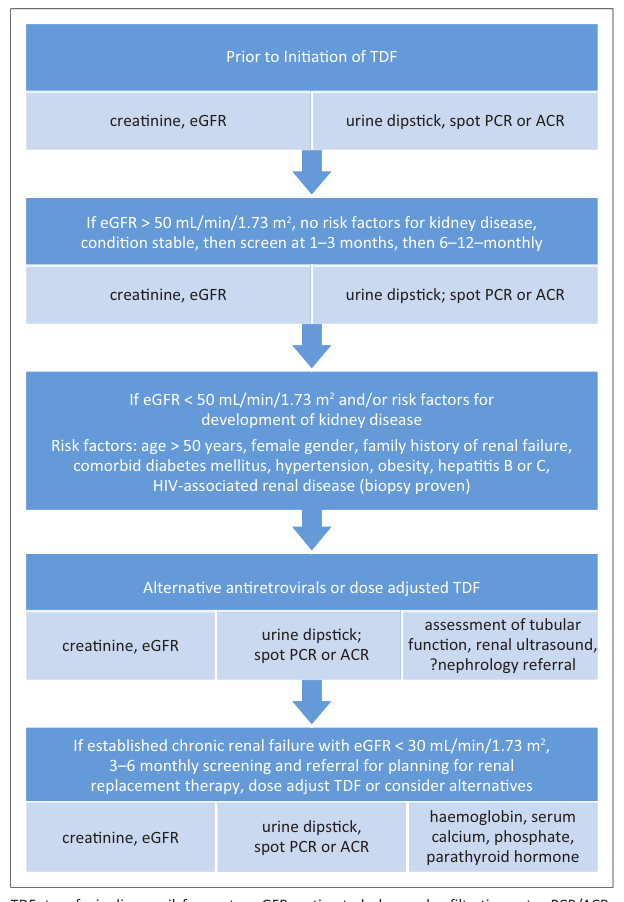
FIGURE 2: Proposed renal screening for those on tenofovir disoproxil